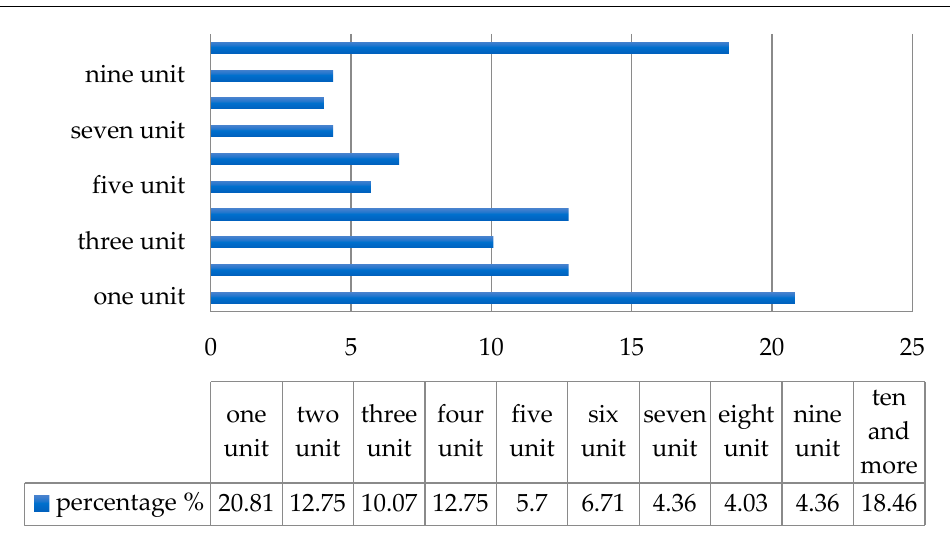
Figure 5. Types of accommodation reported by the respondents.